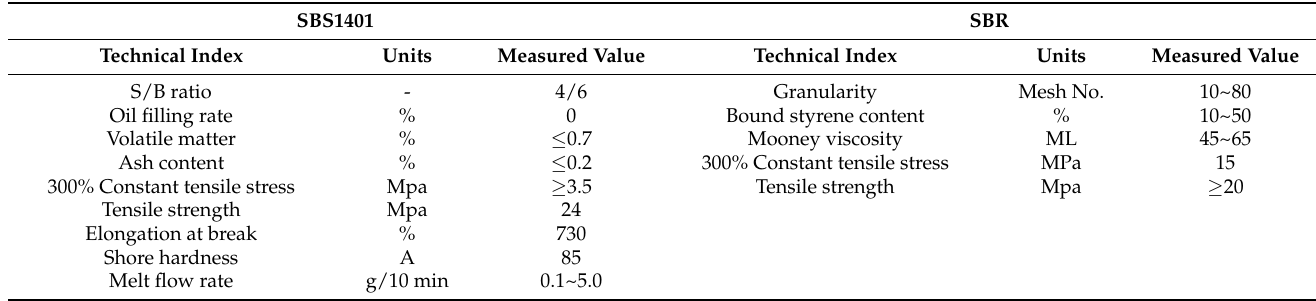
Table 2. Basic technical indexes of SBS and